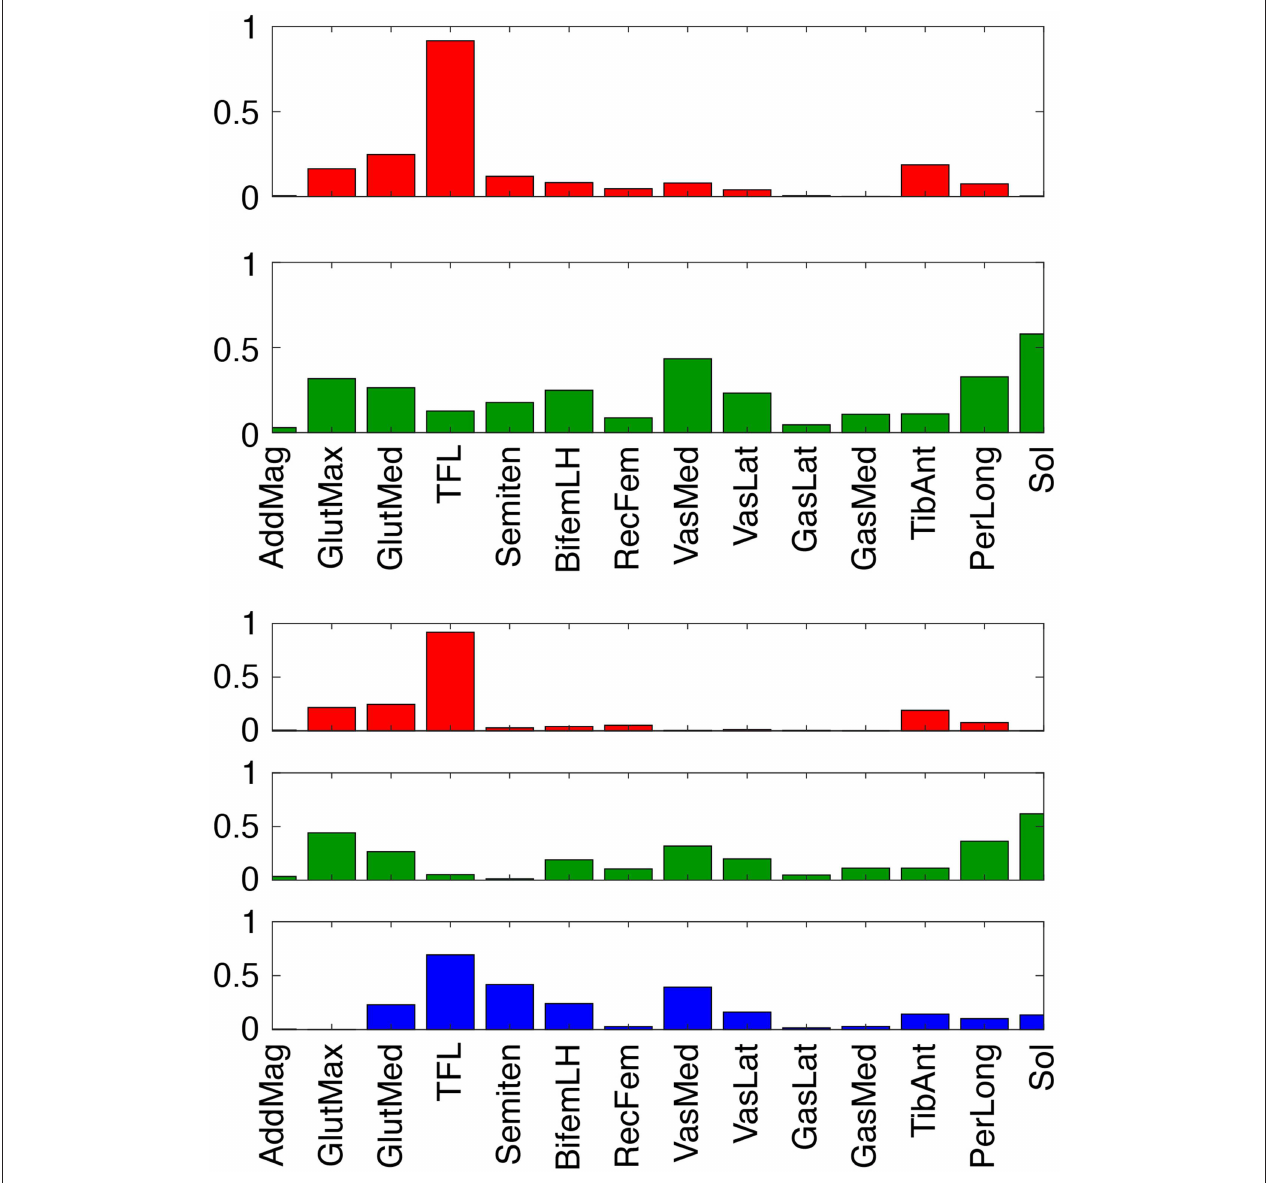
FIGURE 7 | Synergy vectors for 14 paretic leg muscle activations derived from measured EMG signals for 2 (top) and 3 (bottom) synergies. Prior to synergy analysis, measured EMG signals were processed and normalized as part of the muscle-tendon model personalization process. Muscle name abbreviations are listed in Table 1